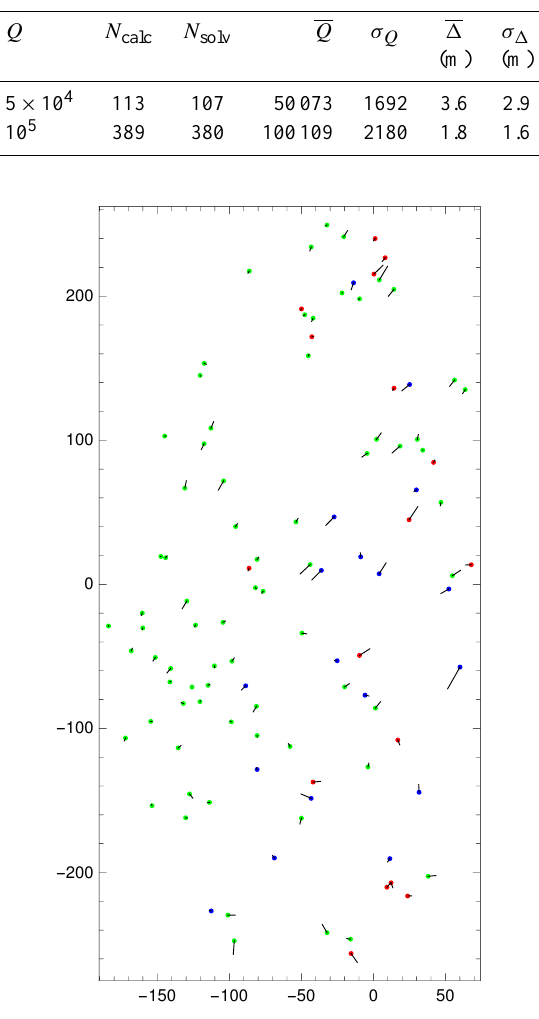
Figure 7. Similar to Fig. 6, with 103 simulations with Q = 5 × 10 4 µmolmol − 1 m 3 s − 1 .